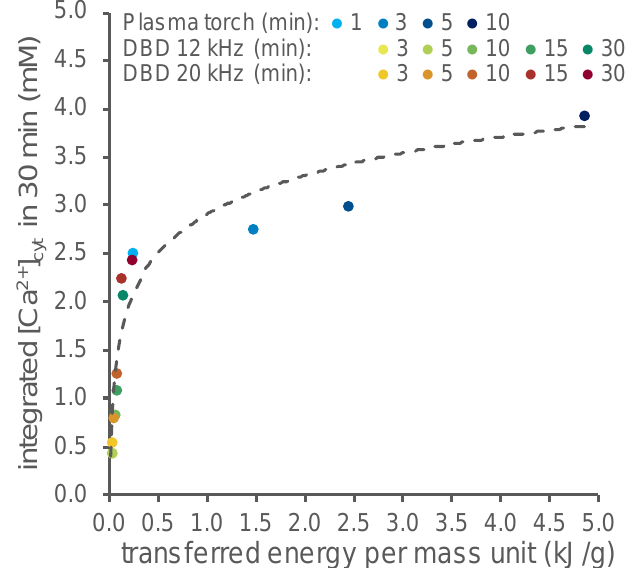
Figure 6. PAW-triggered cytosolic Ca 2+ signals in Arabidopsis versus the total energy transferred to PAW. [Ca 2+ ] cyt dynamics were measured in aequorin-expressing Arabidopsis seedlings after the administration of 1:2 dilutions of either PT-PAW (blue shades) or DBD-PAW. The DBD’s discharge frequency was set either at 12 kHz (green shades) or 20 kHz (red shades). For each set-up, various PAWs were obtained by exposing deionized H 2 O to cold plasma for increasing time intervals (PT- PAW: from 1 to 10 min; DBD-PAW: from 3 to 30 min). Data are the means of the integrated [Ca 2+ ] cyt signals over 30 min in 6 independent seedlings and are plotted against the total energy per unit of mass transferred to water during the various cold plasma treatments.